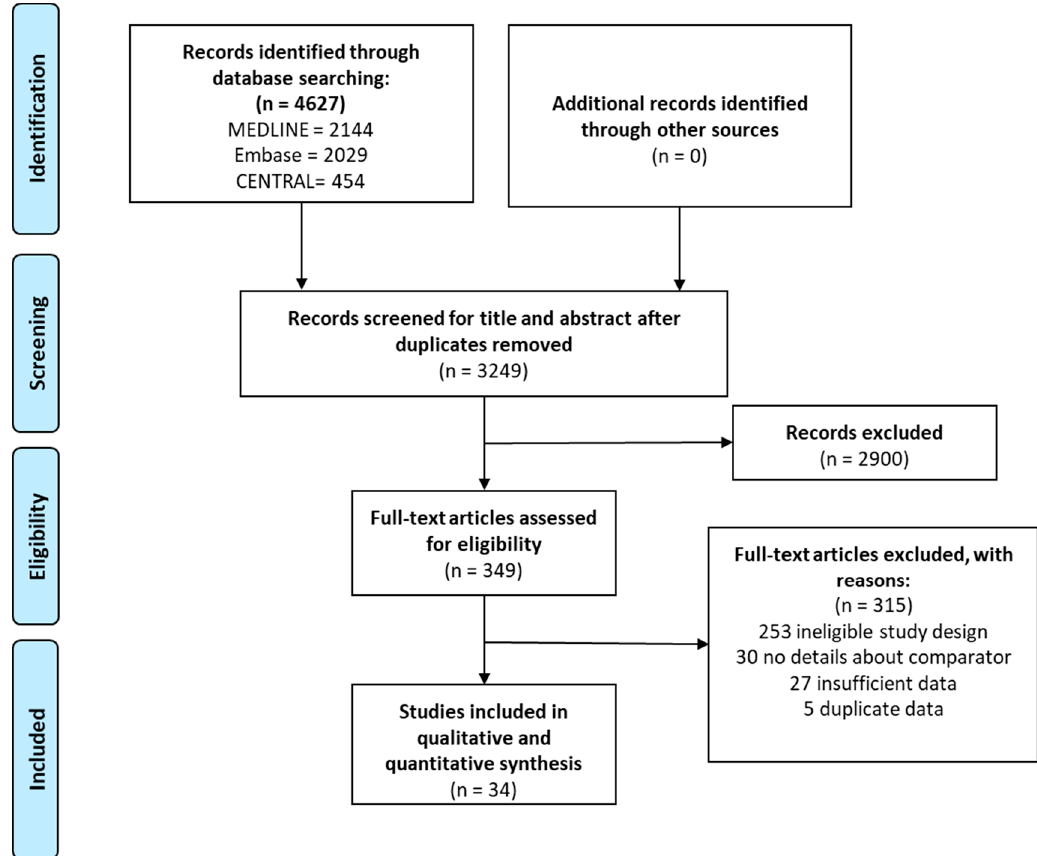
Figure 1. PRISMA flowchart showing the process of systematic search and article selection.